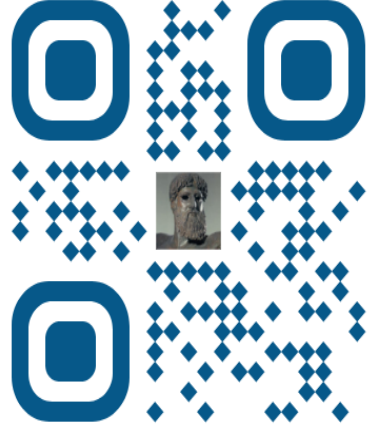
Figure 2. The target image of Poseidon.